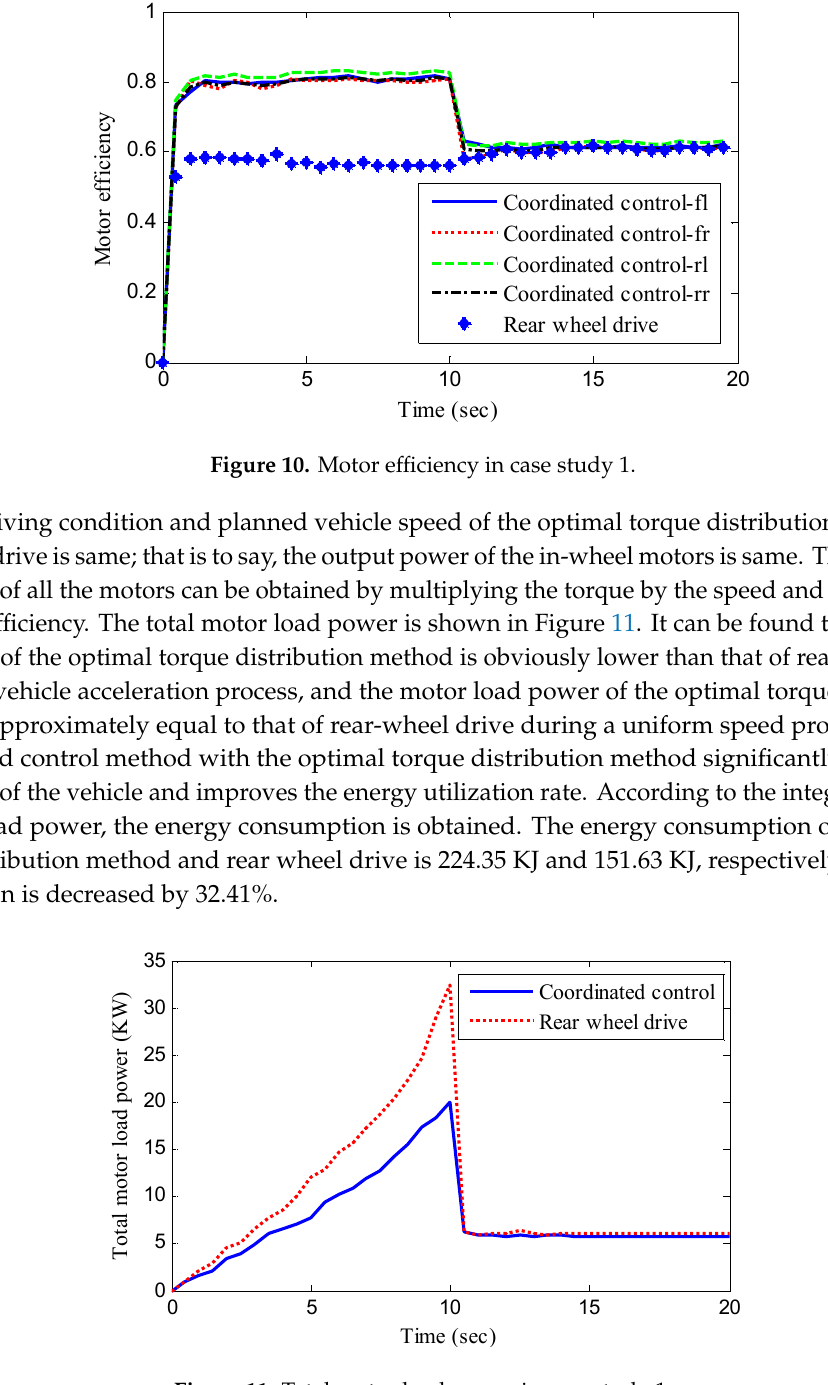
Figure 9. Torque distribution results in case study 1.